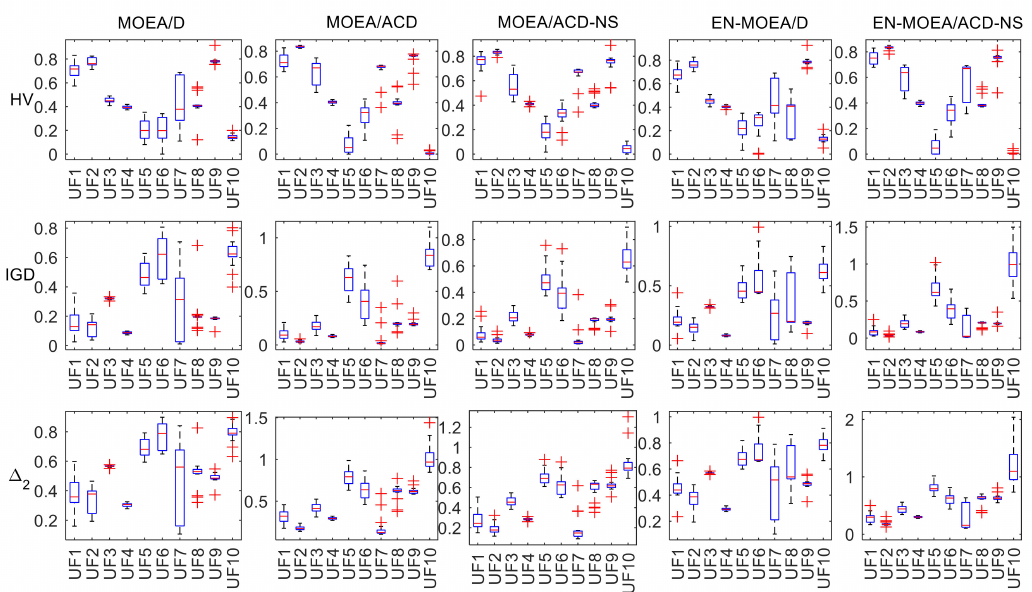
Figure 2. Box plots of the distribution of HV, IGD, and ∆ 2 values using five test algorithms in the